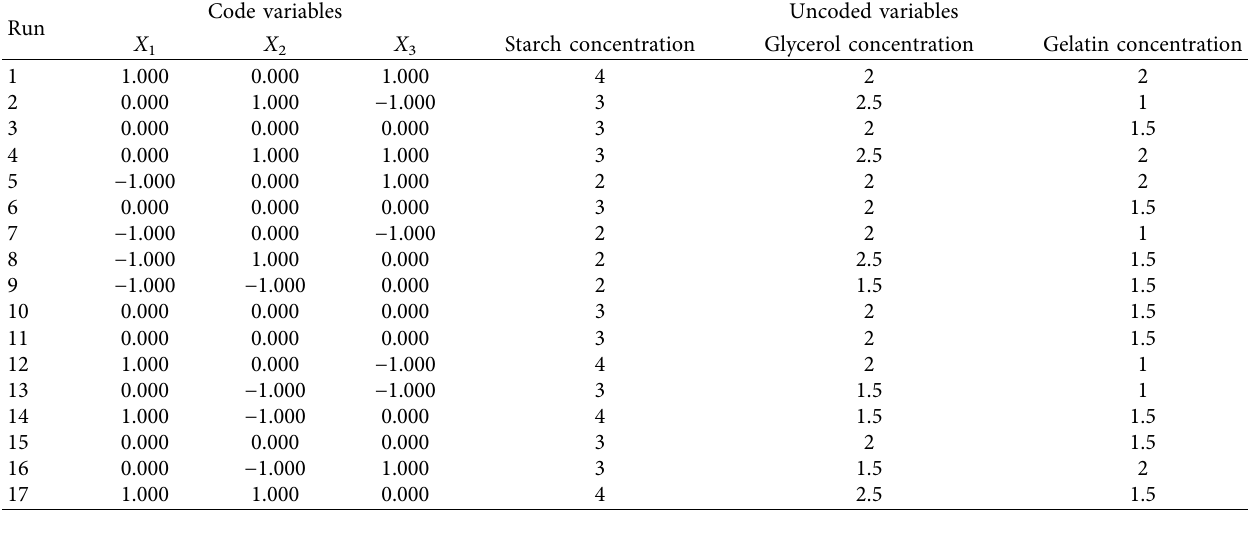
Table 1: Experiments design with coded and uncoded independent variables.